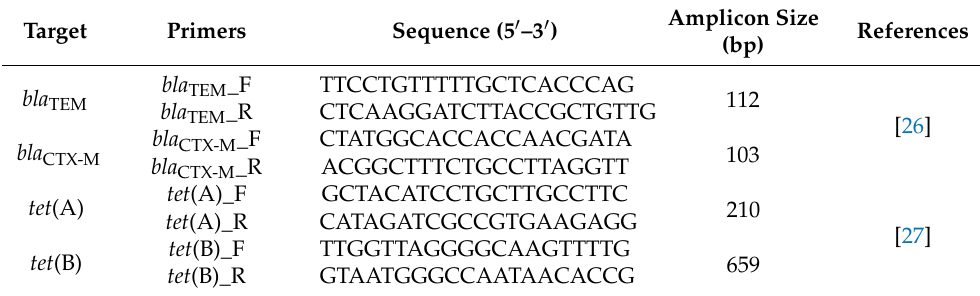
Table 1. Primer used in this study.